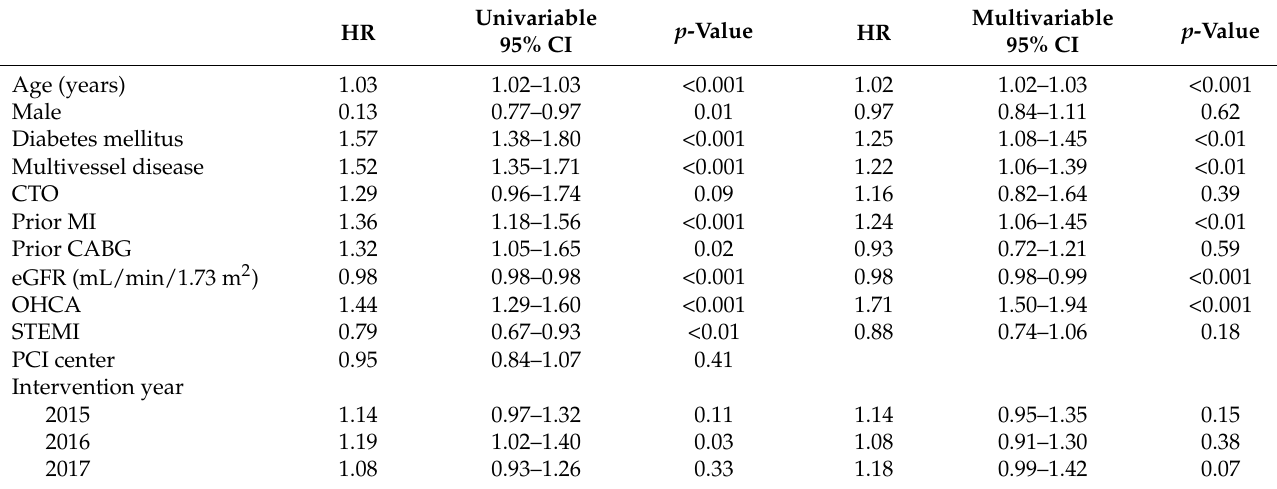
Variables with p < 0.10 in the univariable analysis were included in the multivariable model. STEMI vs. NSTEMI; PCI center vs. heart center; reference intervention year was 2018. CTO, chronic total occlusion; MI, myocardial infarction; CABG, coronary bypass grafting; eGFR, estimated glomerular filtration rate; STEMI, ST-segment elevation myocardial infarction; NSTEMI, non-ST-segment elevation myocardial infarction; PCI, percutaneous coronary